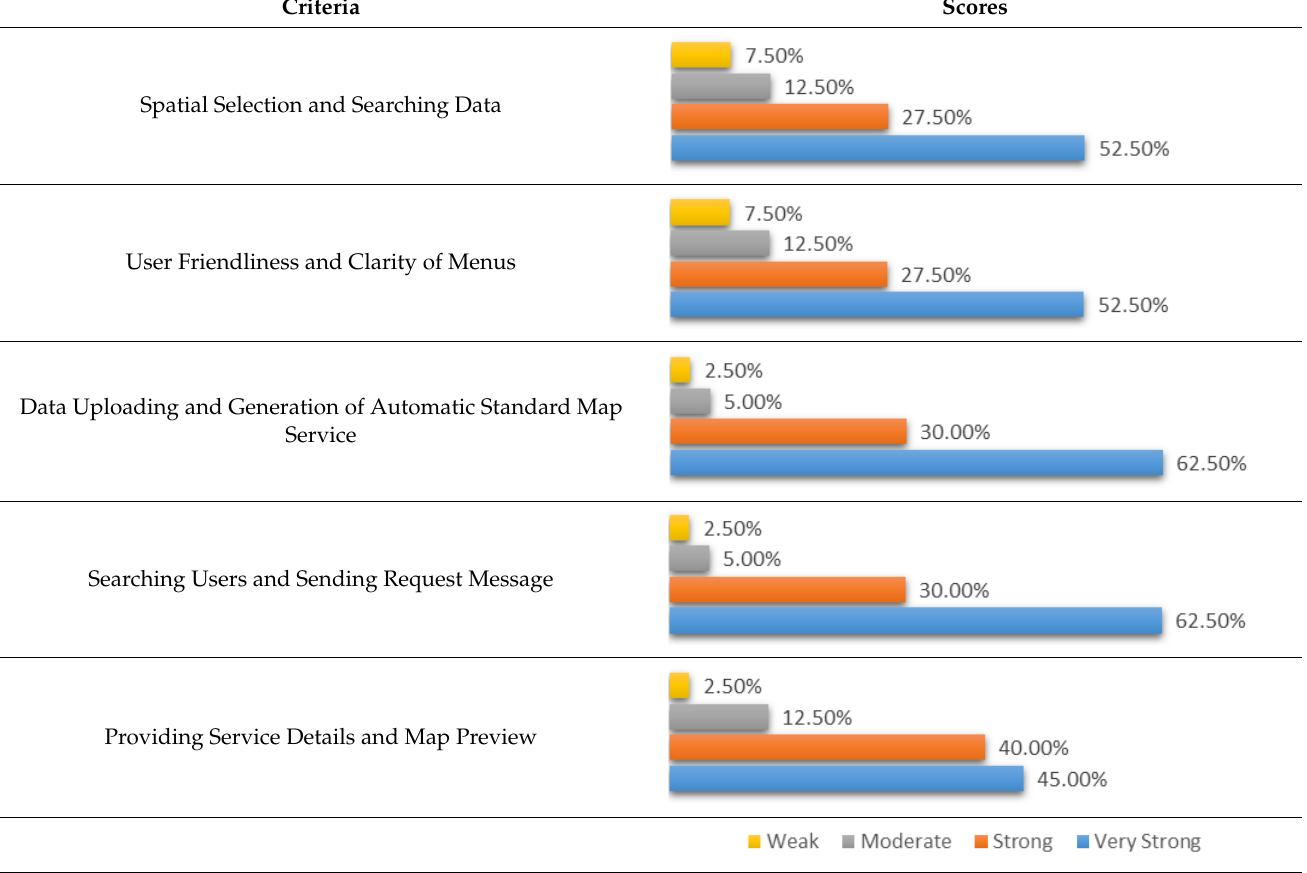
Table 3. Feedback of survey participants on the main capabilities of the implemented prototype of OCCGEOP.